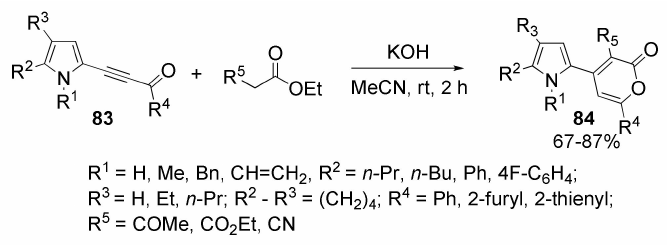
Scheme 46. The synthesis of pyrrolyl pyrones 84